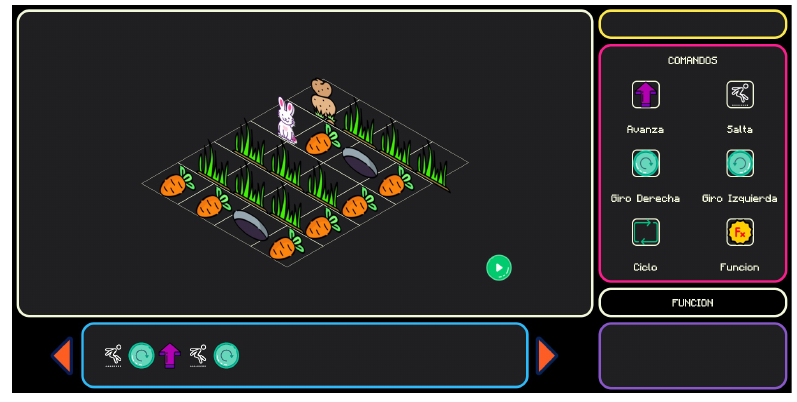
Fig. 8. Preliminary game interface with a board and commands to be